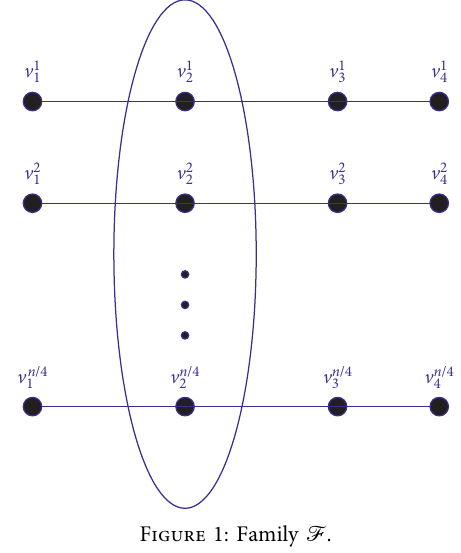
Figure 1: Family F